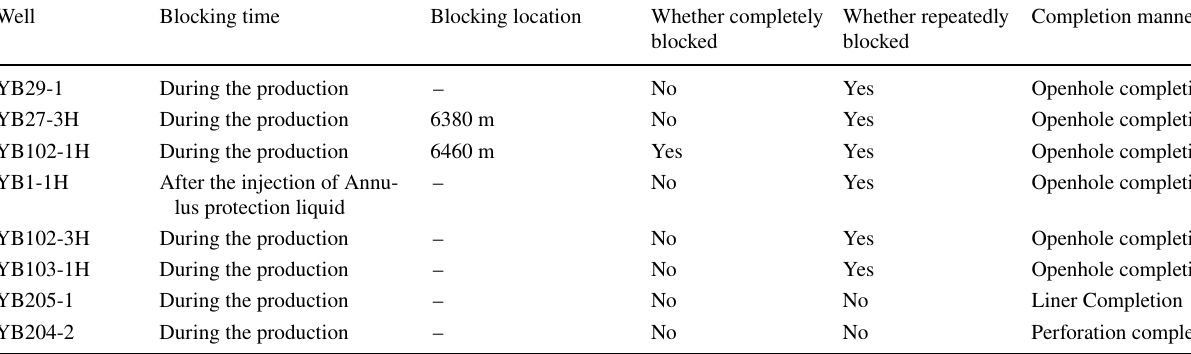
Table 1 Statistics of wellbore compound blockages in Yuanba gas field